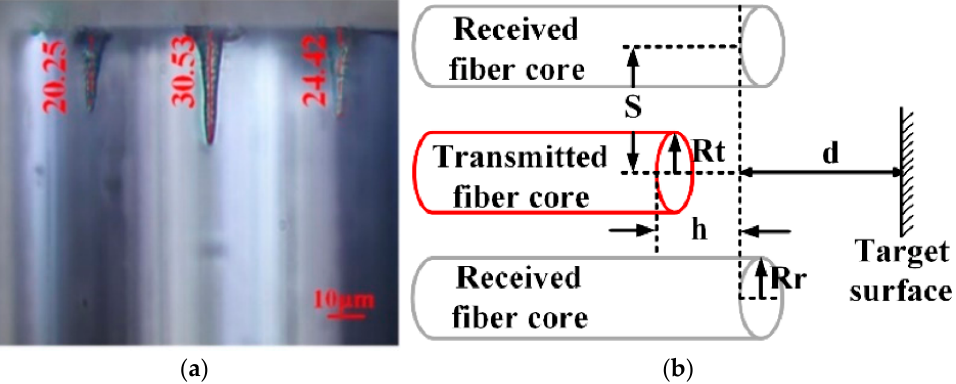
Figure 6. ( a ) Side view of the seven ‐ core fiber after individual micro ‐ hole fabrication; ( b ) schematic design of the axial displacement sensor head [33].